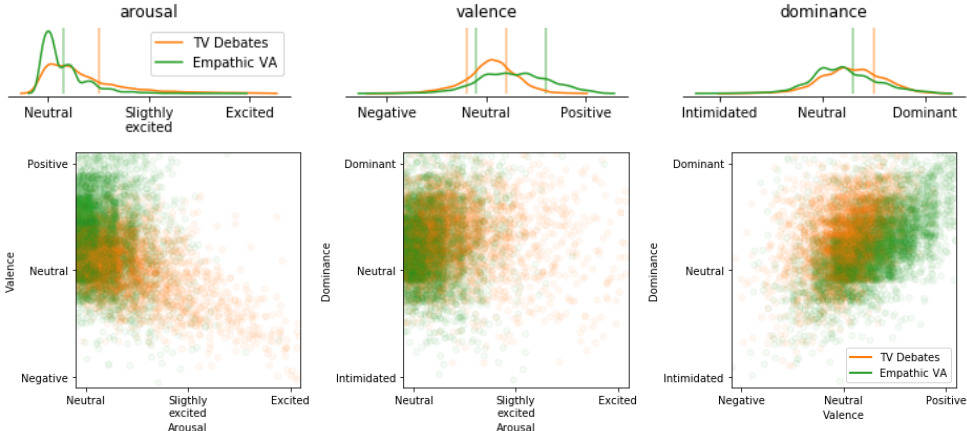
Figure 6. Representation of the VAD dimensional model. In the first row, each of the dimensions is displayed independently, letting us compare each corpus. The vertical lines are the cuts that have been used for the discretization (see Section 3.2). In the second row, a representation of the same dimensions but taken two-by-two is displayed, helping to provide a better understanding of the